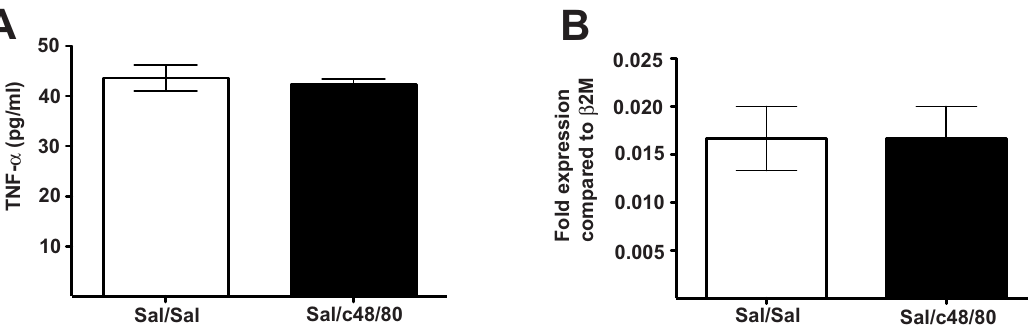
Figure 3. Intra-plantar c48/80 administration does not induce changes in TNF- α protein or mRNA levels in the hind paw tissue of ND4 male mice. Mice were pretreated with 200μg/kg anti-TNF- α neutralizing antibody or vehicle (200μl, i.v. ) 30 minutes before bilateral intra-plantar c48/80 injection (1.5μg/paw; 10μl). 2.5h after c48/80 treatment, their hind paws were excised and preserved for TNF- α protein quantification by ELISA ( A ). Another set of mice was euthanized at 3h after c48/80 treatment; their footpads were excised for TNF- α mRNA abundance quantification by qRT-PCR ( B ). Bars represent average pg/ml TNF- α protein ( A ) and fold-expression of TNF- α transcripts compared to β 2m ( B ) and the error bars represent ±SEM. n = 6 (Sal/Sal); 9 (Sal/c48/80) for ELISA assays and n = 3 mice per treatment group for qRT-PCR; data are representative of 3 (ELISA) and 2 (qPCR)